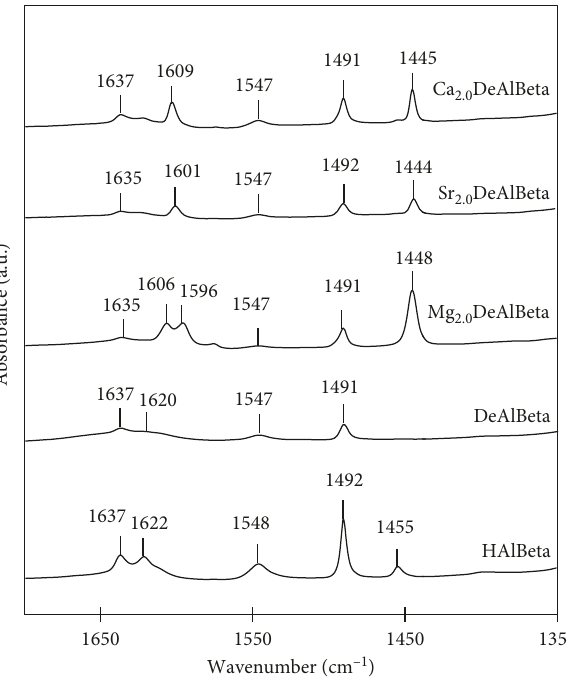
Figure 5: FTIR spectra of HAlBeta, DeAlBeta, Mg Sr 2.0 DeAlBeta, and Ca 2.0 DeAlBeta samples recorded at room temperature after adsorption at room temperature and desorption of pyridine at 300 °